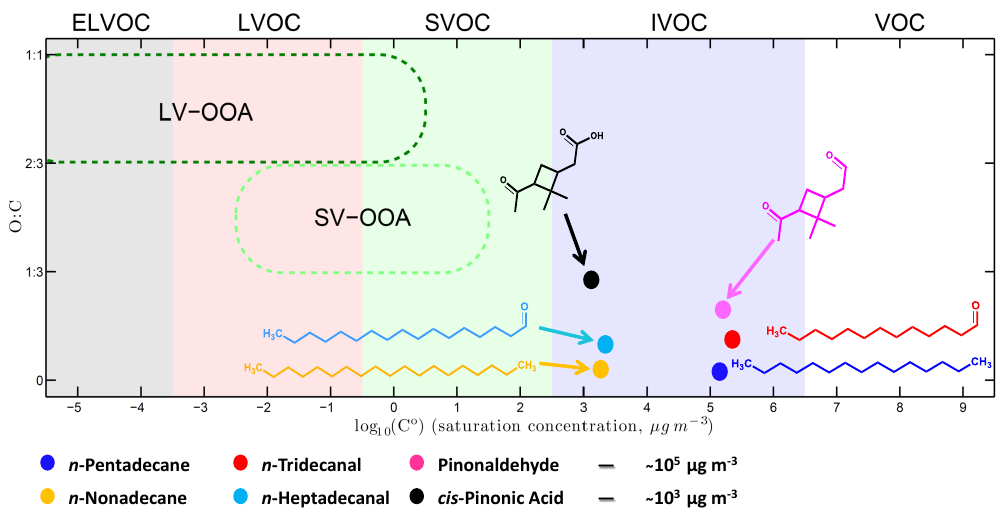
Fig. 2. Two sequences of molecules with progressively increasing oxidation state but similar vapor pressures ( ∼ 10 5 and ∼ 10 3 µgm − 3 ), shown in a two-dimensional volatility-oxidation state space. The 10 5 µgm − 3 sequence is: n -pentadecane, n -tridecanal, pinonaldehyde, and 2- and 7-tridecanone (co-located with n -tridecanal). The 10 3 µgm − 3 sequence is: n -nonadecane, n -heptadecanal and cis -pinonic acid. The species lie in the intermediate volatile organic carbon (IVOC) range occupied by many first-generation oxidation products associated with secondary organic aerosol (SOA) formation. Pinonaldehyde and cis -pinonic acid are first-generation products of α -pinene oxidation. Ambient oxidized organic aerosol (OOA) lies in the ranges indicated, with SV-OOA being fresher, less oxidized and more volatile and LV-OOA being more aged and less